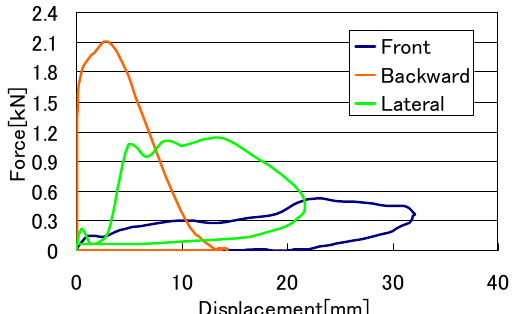
Fig. 7 Force–displacement curve of the thoracic structure for impacts at 15.2 [km/h] for each impact